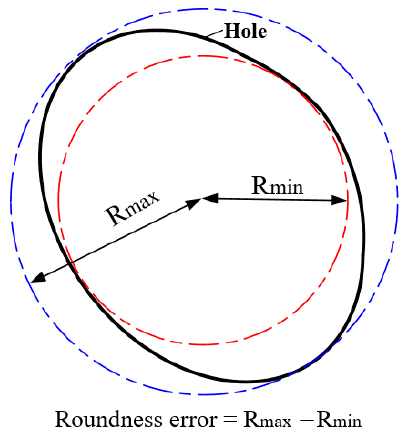
Figure 7. Roundness error calculation method.